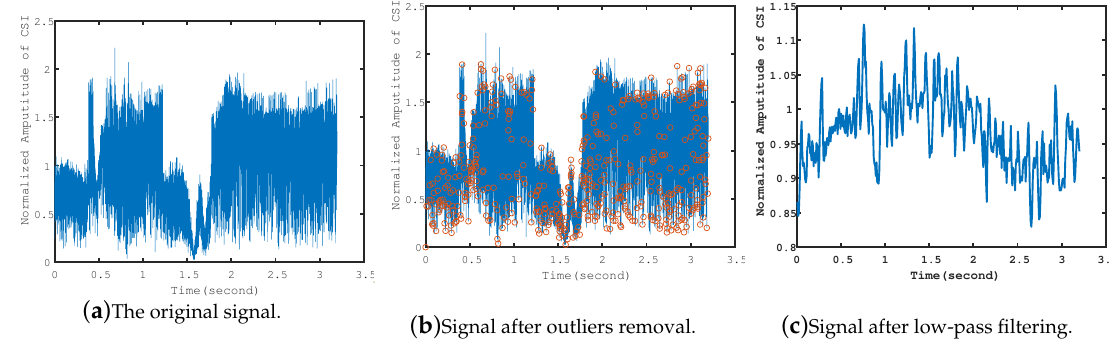
Figure 4. The results of